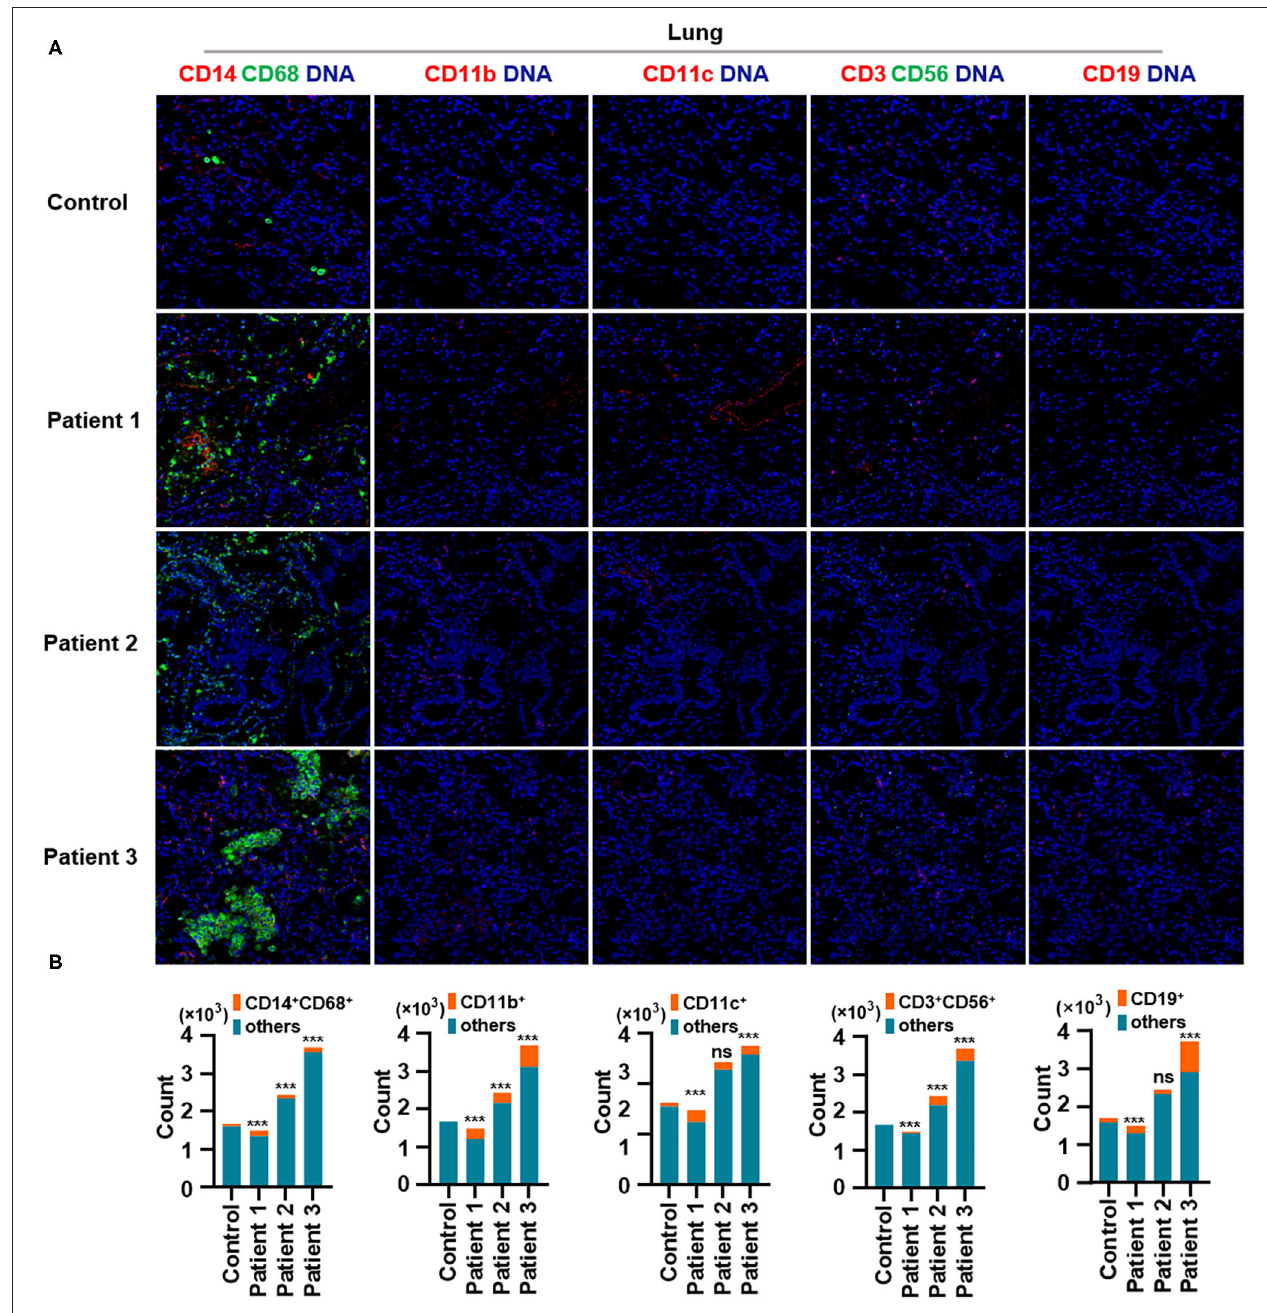
FIGURE 2 | Immune cell responses to severe acute respiratory syndrome coronavirus 2 (SARS-CoV-2) in the lungs of patients with coronavirus disease-2019 (COVID-19). Representative imaging mass cytometry (IMC) for each panel, with different colors to distinguish panels; iridium-DNA staining is shown in blue. (A) Monocytes (CD14 and CD68), CD11b + macrophages, CD11c + dendritic cells (DCs), natural killer T (NKT) cells (CD3 and CD56), and B cells (CD19) in the lungs of controls and three patients with COVID-19. (B) Bar plot for the comparison of monocyte (CD14 and CD68), CD11b + macrophage, CD11c + DC, NKT cell (CD3 and CD56), and B cell (CD19) counts in the lungs of controls and three patients with COVID-19. The significance of differences between groups is shown in horizontal brackets and was assessed using Fisher’s exact test. *** P < 0.01; ns, P >